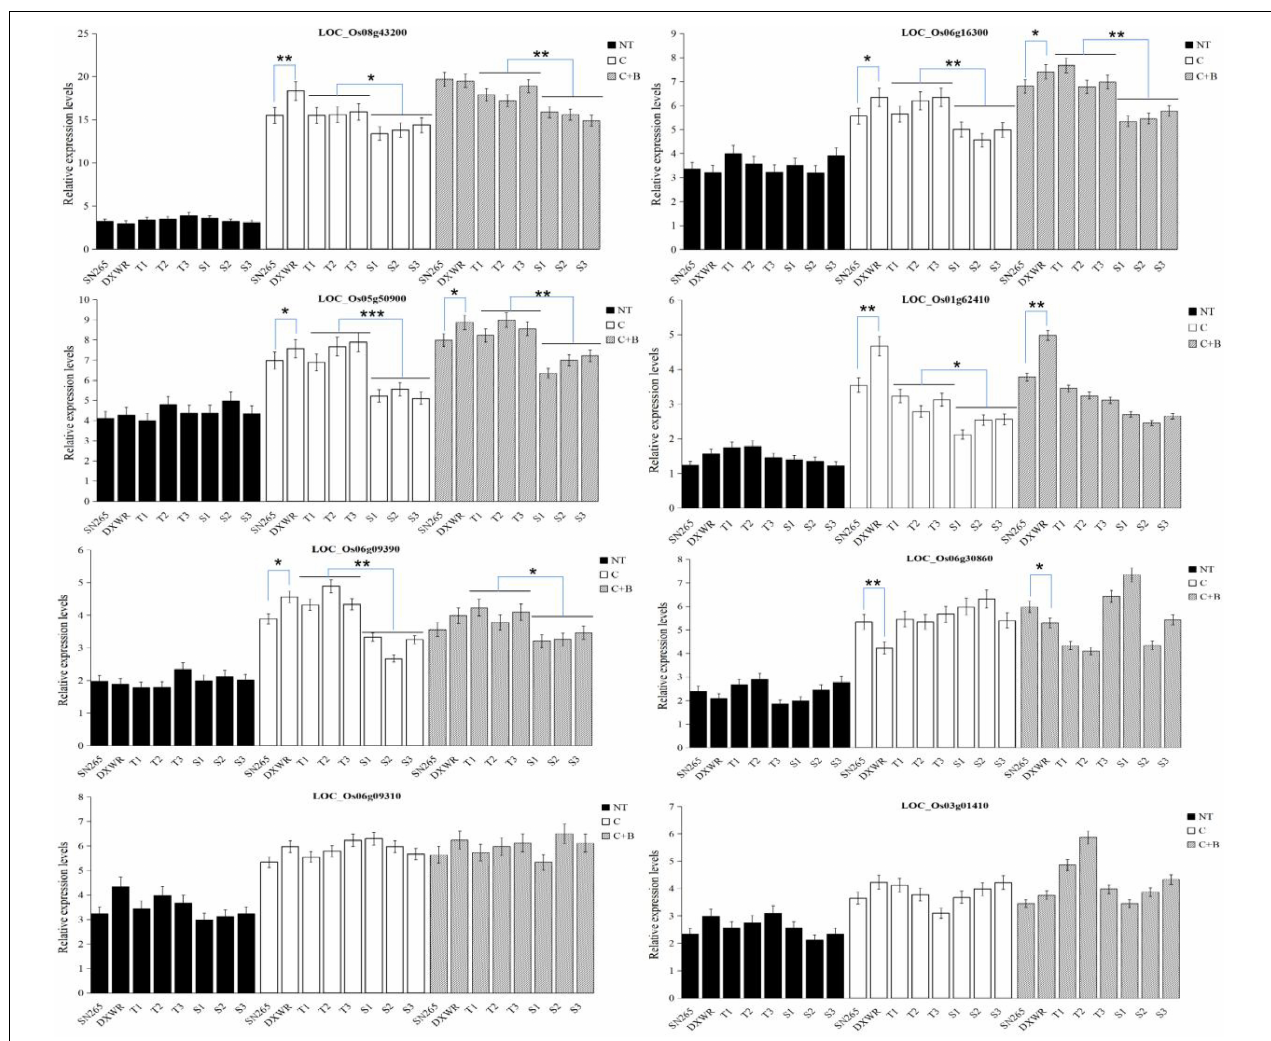
FIGURE 5 | Expression patterns of the candidate genes. Biological triplicates were averaged and statistically analyzed via Student’s t -test (* P < 0.05; ** P < 0.01; ***textitP < 0.001). NT, normal temperature; C, cold stress; C + B, BR-combined cold